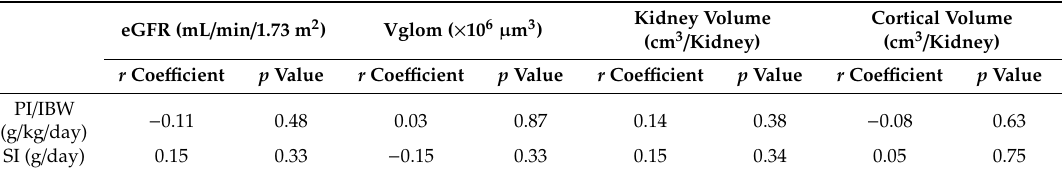
Figure 1. Correlations between diet‑related parameters and single‑nephron glomerular filtration rate. Associations ( a ) between estimated protein intake/ideal body weight (PI/IBW) and single‑nephron glomerular filtration rate (SNGFR Cr ), and ( b ) between sodium intake (SI) and SNGFR Cr . Measures of association were tested by Pearson’s correlation coefficient. Solid lines indicate lines of best fit. Dotted lines show 95% confidence intervals. ( c ) SNGFR Cr values in the low, intermediate, and high PI/IBW groups. Bold lines indicate 95% confidence intervals. The statistical test for trend shows that SNGFR Cr tends to increase significantly with increasing PI/IBW. Differences among groups are analyzed by the Jonckheere–Terpstra test. Table 3. Correlation analyses of study parameters.